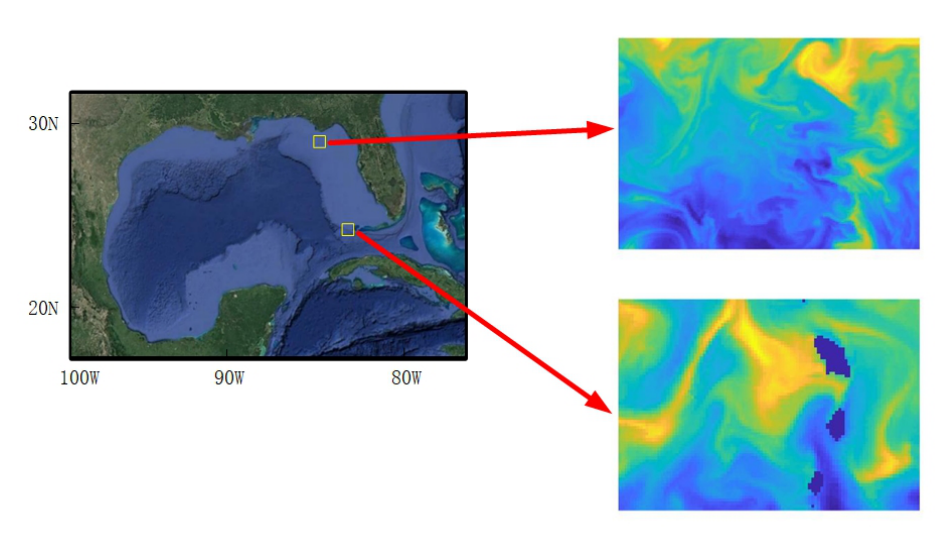
Figure 1. The geographical map for Gulf of Mexico. Two areas are selected for scenario 1 and 2.